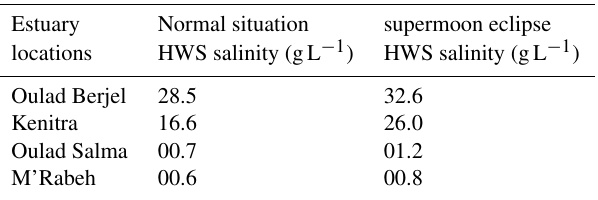
Table 10. Comparisons salinity variation at HWS in different loca-